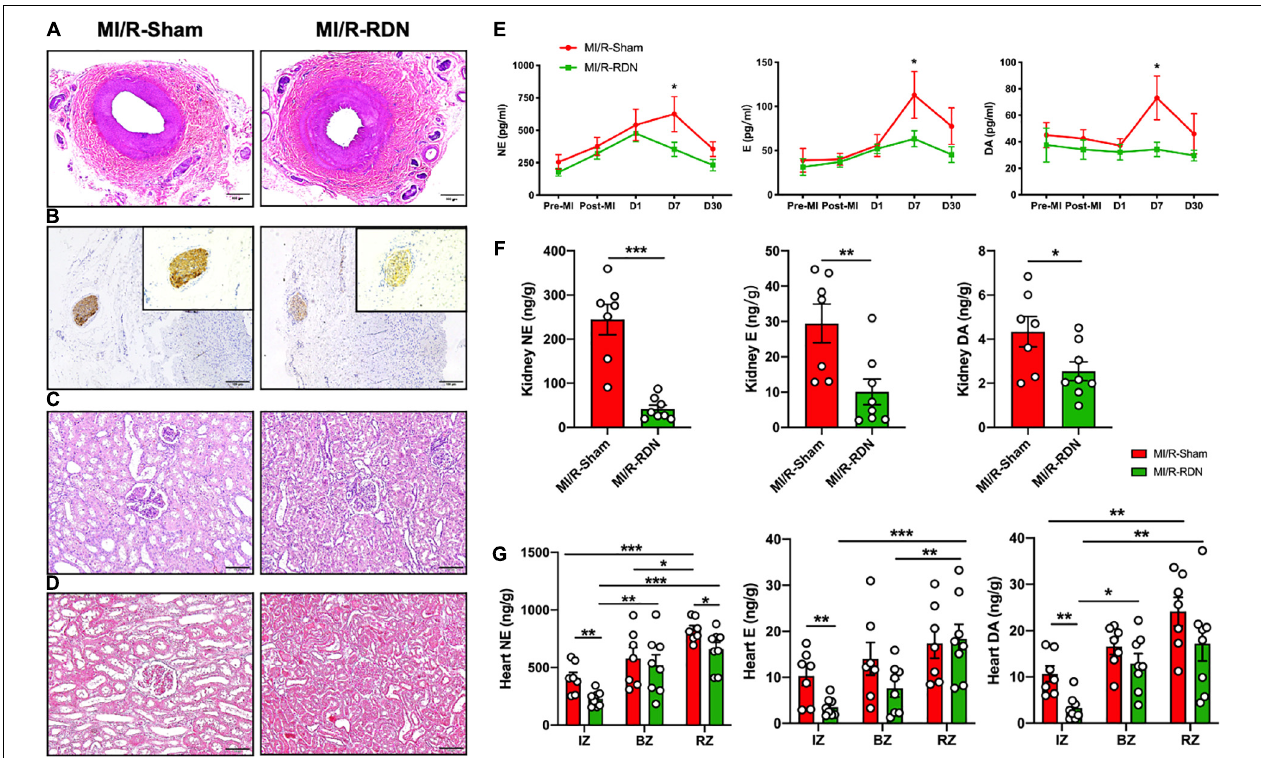
FIGURE 3 | Histological staining of the kidneys and renal arteries and catecholamine levels in the circulation, renal cortex, and heart. (A) Representative images of hematoxylin and eosin (HE) staining of the renal arteries at the 30-day endpoint following sham or RDN therapy. (B) Representative images of tyrosine hydroxylase (TH) staining on the nerves in the adventitial layer of the renal arteries at the 30-day endpoint following sham or RDN therapy. Inserts indicate renal artery nerves and magnified photomicrographs (20 × ) of TH staining. The scale bar is 100 mm. (C) Representative images of HE staining of the kidney at the 30-day endpoint following sham or RDN therapy. The scale bar is 100 mm. (D) Representative images of Masson’s trichrome staining of the kidney at the 30-day endpoint following sham or RDN therapy. The scale bar is 100 mm. (E) Norepinephrine (NE), epinephrine (E), and dopamine (DA) concentrations in the circulation pre-AMI, post-AMI, and 1, 7, and 30 days post-RDN. (F) NE, E, and DA concentrations per gram of kidney cortex tissue. (G) NE, E, and DA concentrations per gram of heart IZ, BZ, and RZ tissue. n = 7 in the IM/R-Sham group, n = 8 in the IM/R-RDN group. IZs, infarct zones; BZs, border zones; and RZs, remote zones. Data are shown as the mean ± SEM (E–G) . p -Values were obtained by two-way ANOVA with Bonferroni test (E) , unpaired, two-tailed t -test (F) , and two-tailed t -test and one-way ANOVA with Bonferroni test (G) . * p < 0.05, ** p < 0.01, and *** p < 0.001 (compared with the MI/R-Sham or MI/R-RDN